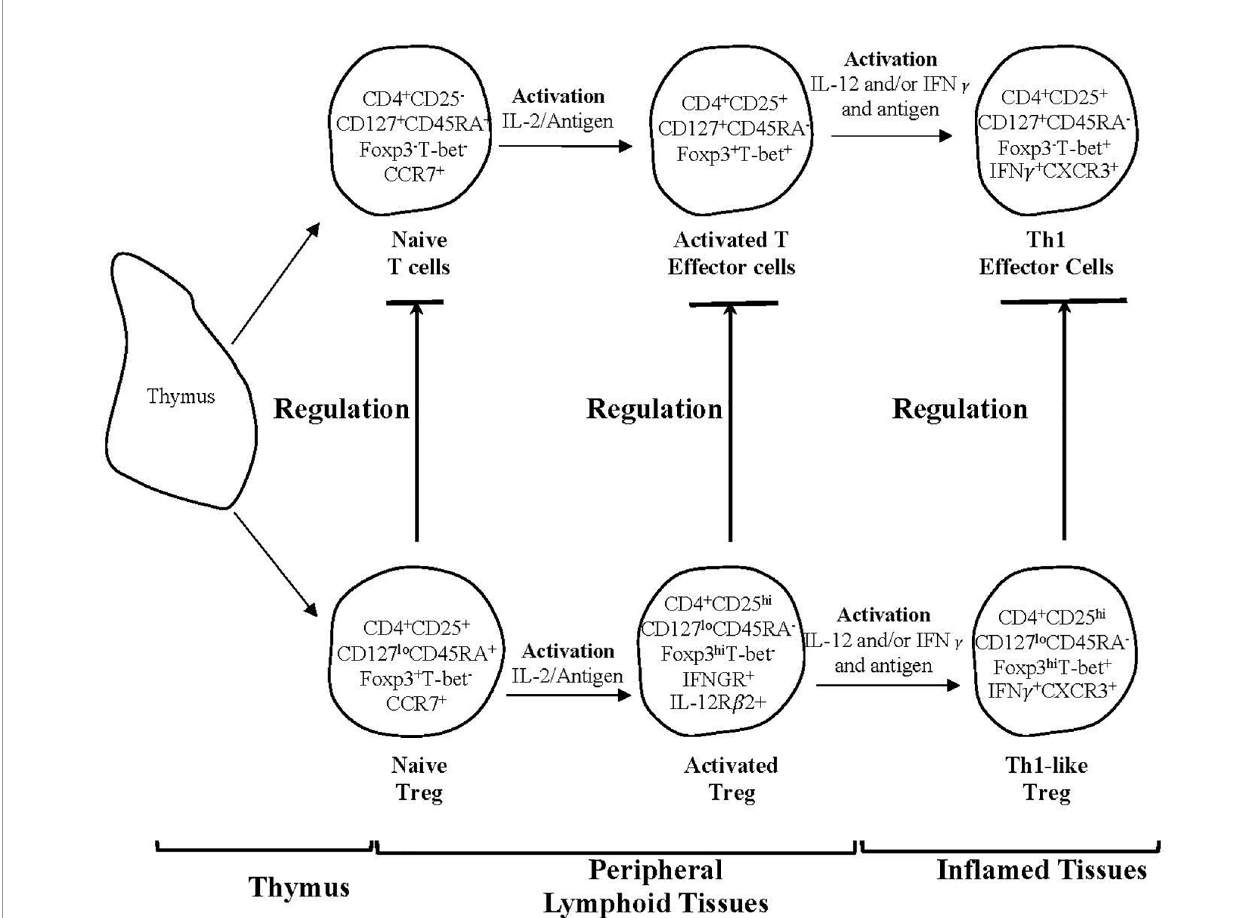
FIGURE 3 | A schematic representation of two subpopulations of CD4 + T cells produced by the thymus and one of several pathways for their activation by an antigen and cytokines in peripheral lymphoid tissues and sites of in fl ammation. The activation by an antigen of effector lineage CD4 + CD25 - CD127 + CD45RA + Foxp3 - cells induces them to produce cytokines that promotes activation of CD25 + CD127 lo CD45RA + Foxp3 + Treg that have been activated by antigen. This fi gure shows the parallel pathways of activation of effector and regulatory CD4 + T cells, when producing and being activated by Type-1 cytokines. The cytokines produced by the effector cells are required for the full activation of Treg. Both lineages of cells have been produced by thymus and have migrated to peripheral lymphoid tissue. Their subsequently recirculation from lymphoid tissue to blood and back to lymphoid tissue, is promoted by expression of CD62L and CCR7. This recirculation increases their chances of recognizing antigens. In peripheral lymphoid tissue upon recognition of an antigen, both effector and regulatory CD4 + T cell populations are activated and proliferate. Effector lineage CD4 + T cells start producing IL-2 and express IL-2R including CD25 (IL-2Ra chain). Naïve resting Treg expand polyclonally. During an immune response naïve/resting CD4 + CD25 + CD127 lo CD45RA + Foxp3 + T-bet - CCR7 + Treg are activated by an antigen and the IL-2 produced by activated T effector cells and are induced to express the receptor for late Th1 cytokines IL-12 and IFN − g . Naïve CD4 + CD25 + CD127 + CD45RA + Foxp3 - T-bet - CCR7 + T cells also acquire CD25, Foxp3 and T-bet expression but no longer express CD45RA. Transient expression of Foxp3 and CD25 on activated effector T cells blurs the distinction between Treg and effector T cells. In the event of ongoing immune response, activated T effector cells, in the presence of IL-2 and IFN- g get further activated to express the transcription factor t-bet and the chemokine receptor CXCR3. These activated effector CD4 + T cells produce IFN- g , which together with IL-12 further activate Treg to Th1-like Treg (CD4 + CD25 hi CD127 lo CD45RA - Foxp3 hi T-bet + IFN- g + CXCR3 + ). Th1-like Treg express mRNA for Th1 transcription factor T-bet, Th1 cytokine IFN- g and Th1 chemokine receptor CXCR3. Expression of CXCR3 enables these Treg to migrate to in fl amed tissues, where they control immune in fl ammation as in the graft and promote tolerance. Th-like Treg, such as Th1-like Treg are the mediators of transplant tolerance and are a hundred to a thousand- fold more potent at suppression of rejection than naïve resting Treg. This fi gure only represents one pathway of activation of Treg and there are others such as Th-2 like Treg promoted by Th2 cells and Type-2 cytokines. The survival of highly activated Treg is dependent on continued antigen stimulation and key cytokines produced by the in fl ammatory response, IL-2 alone does not sustain these cells and may inhibit